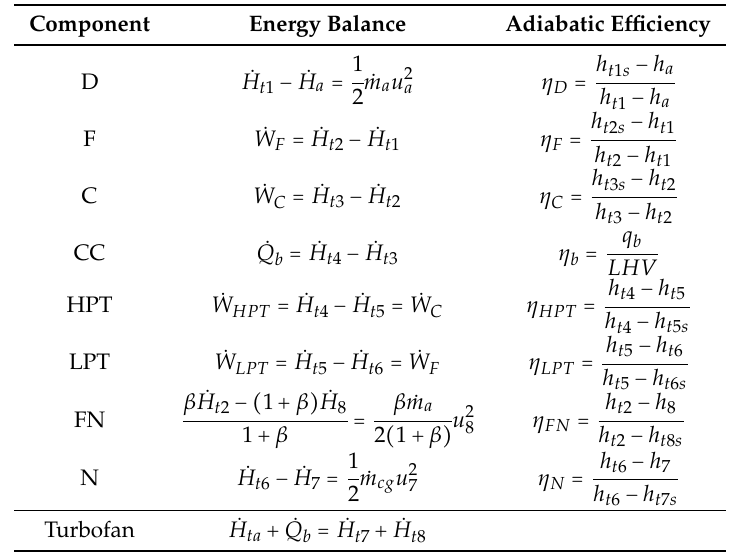
Table 1. Energy balance and adiabatic efficiency of the turbofan